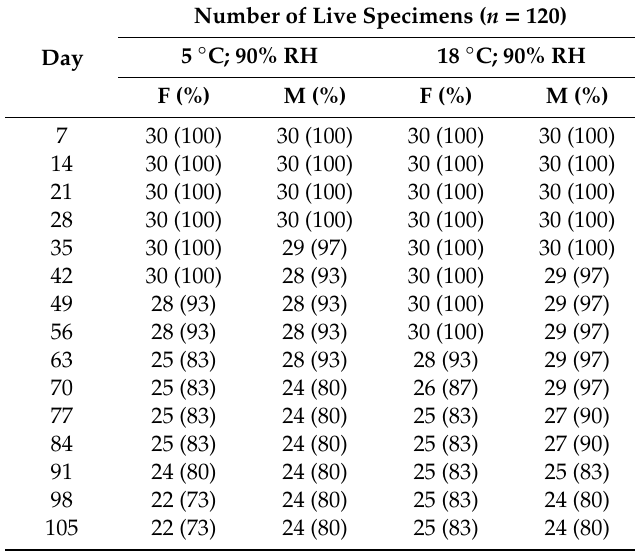
Table 3. Survival rates in adult Dermacentor reticulatus ticks in laboratory conditions in the period of 13 November 2018–25 February 2019; the observations were carried out at equal 7-day intervals. Number of Live Specimens ( n = 120) 5 ◦ C; 90% RH 18 ◦ C; 90% RH Day F